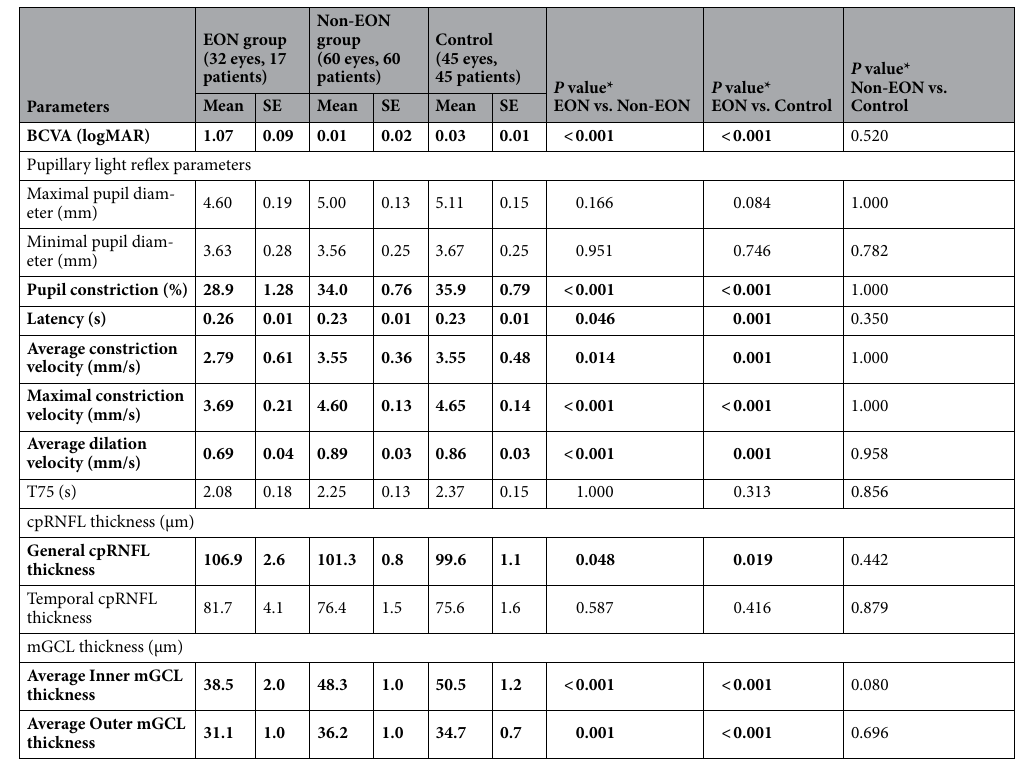
Table 1. Comparison of the pupillary light reflex and optical coherence tomography parameters among the three groups. Factors with statistical significance are shown in boldface; BCVA = best corrected visual acuity; cpRNFL = circumpapillary retinal nerve fiber layer; EON = ethambutol-induced optic neuropathy; logMAR = logarithm of the minimum angle of resolution; mGCL = macular ganglion cell layer; SE = standard error; T75 = Total time taken by the pupil to recover 75% of the maximal pupil diameter. *The generalized estimating equation was used for values accounting for intereye correlations. Both eyes were included in the analyses. Covariates were sex and presence of diabetes mellitus. P value by post hoc